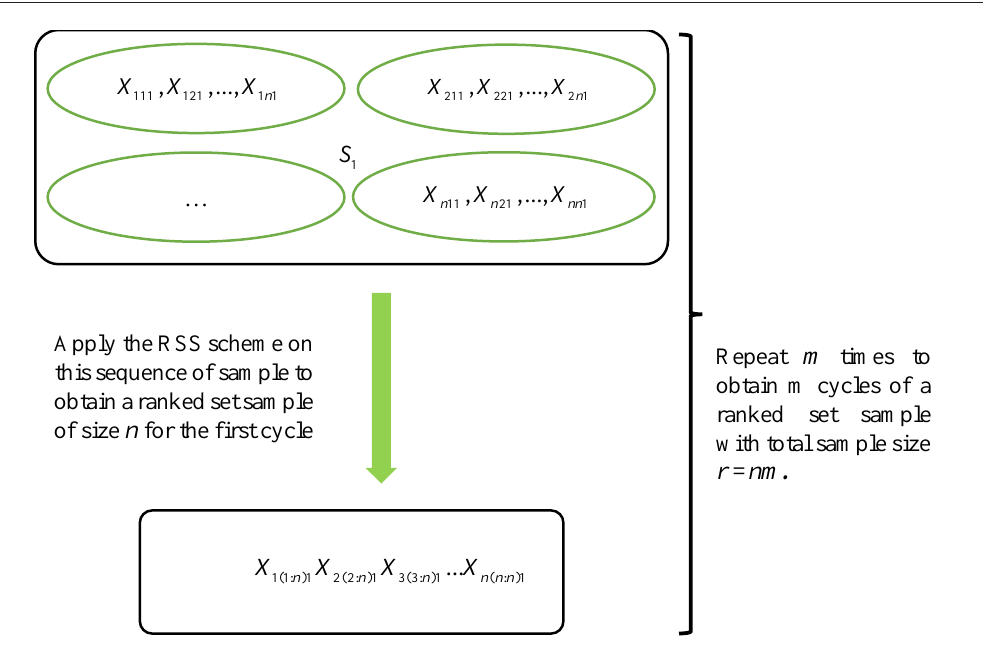
Fig. 1. The procedure to obtain the first set of RSS data in the first